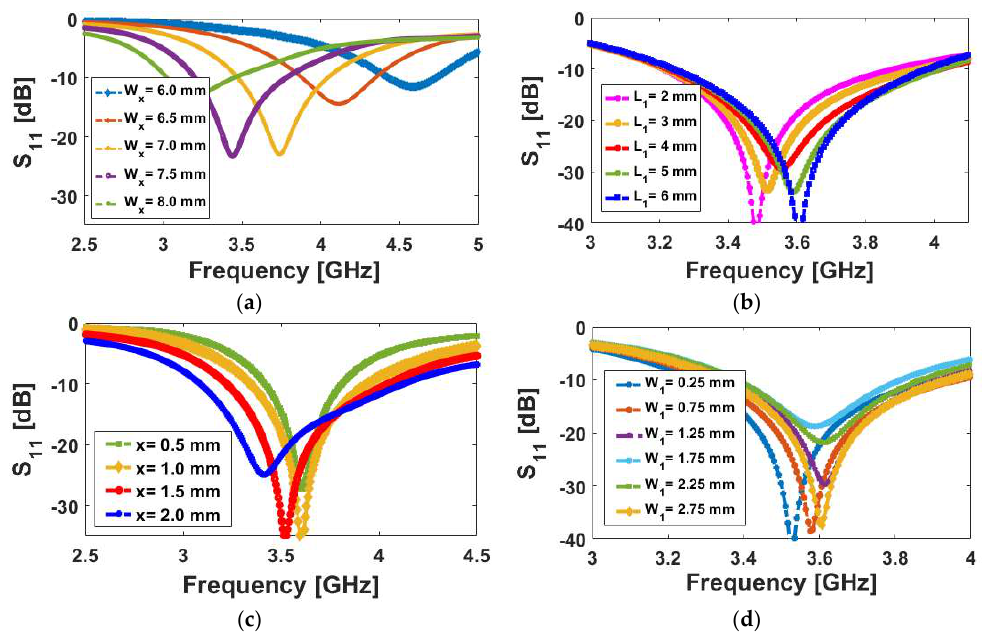
Figure 3. S 11 results of the diamond-ring antenna for various values of ( a ) W x , ( b ) L 1 , ( c ) x, and ( d ) W 1 .